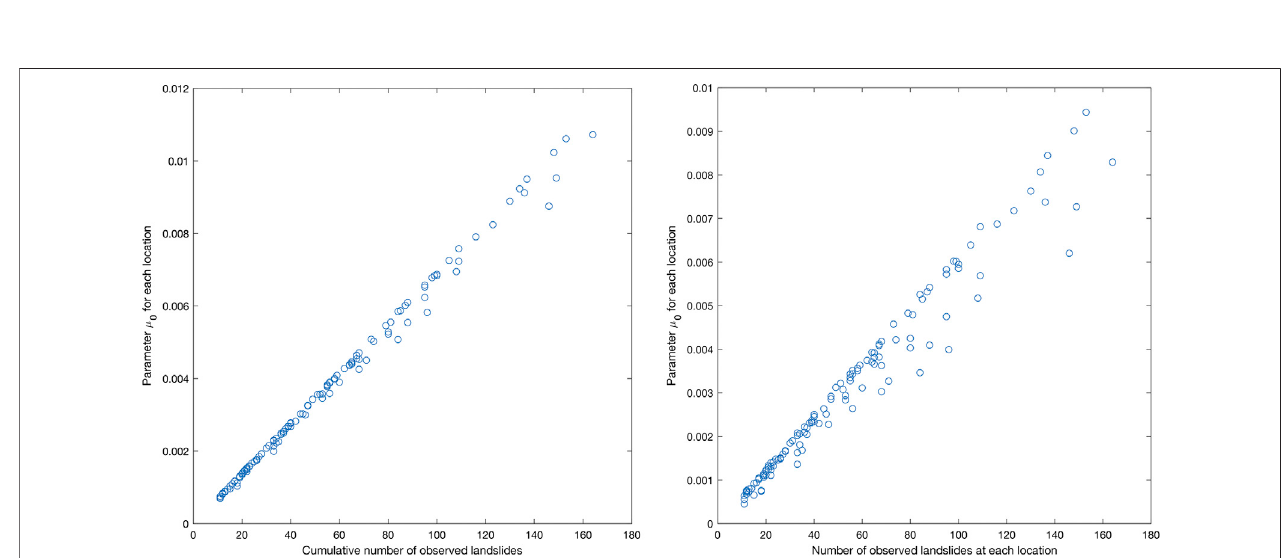
FIGURE 7 | Estimated location susceptibilities for Model 2D (left) and 2B (right).